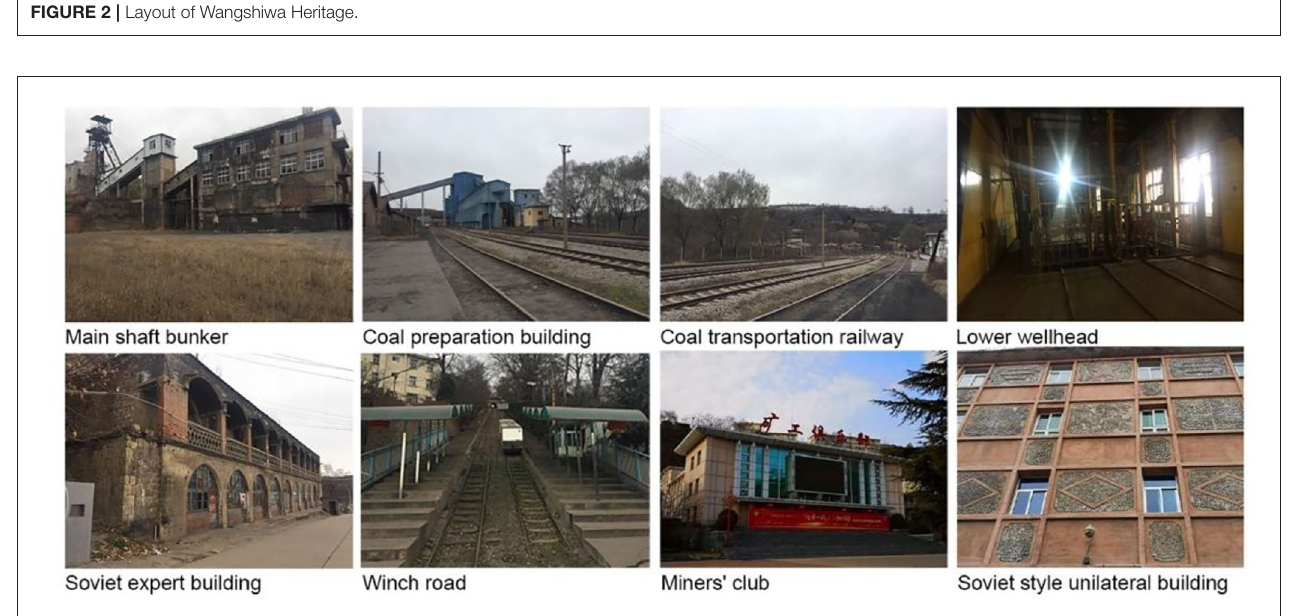
FIGURE 3 | Current situation of Wangshiwa Coal Mine.